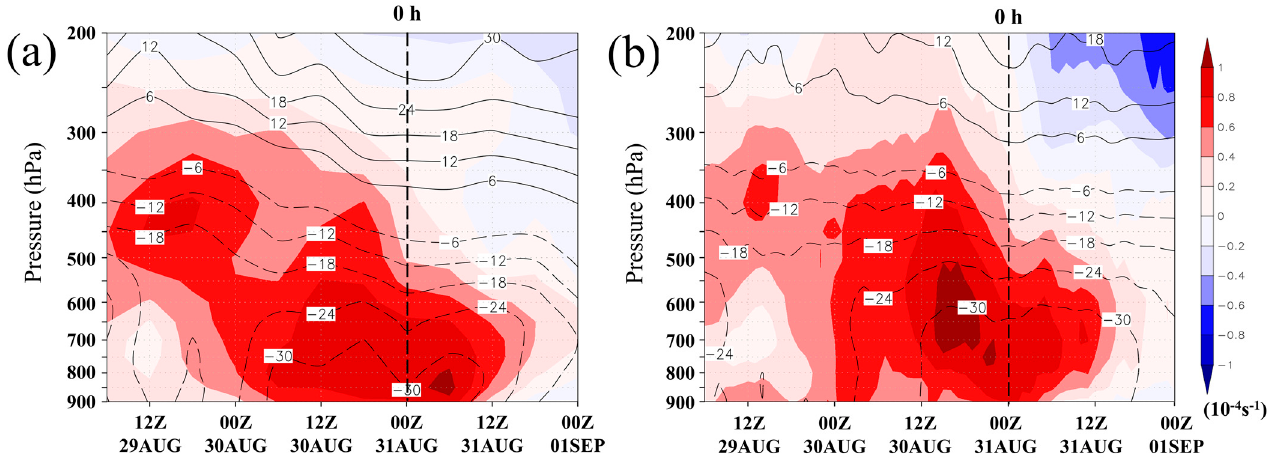
Figure 7. Time-height section of relative vorticity (shading; 10 − 4 s − 1 ) and geopotential height anomaly (contour; gpm), relative to the areal average over 110° E to 130° E, 15° N to 35° N, averaged over 118° E to 121° E, 23.5° N to 26.5° N of ( a ) ERA-Interim (6-h) and ( b ) CTRL (1-h).